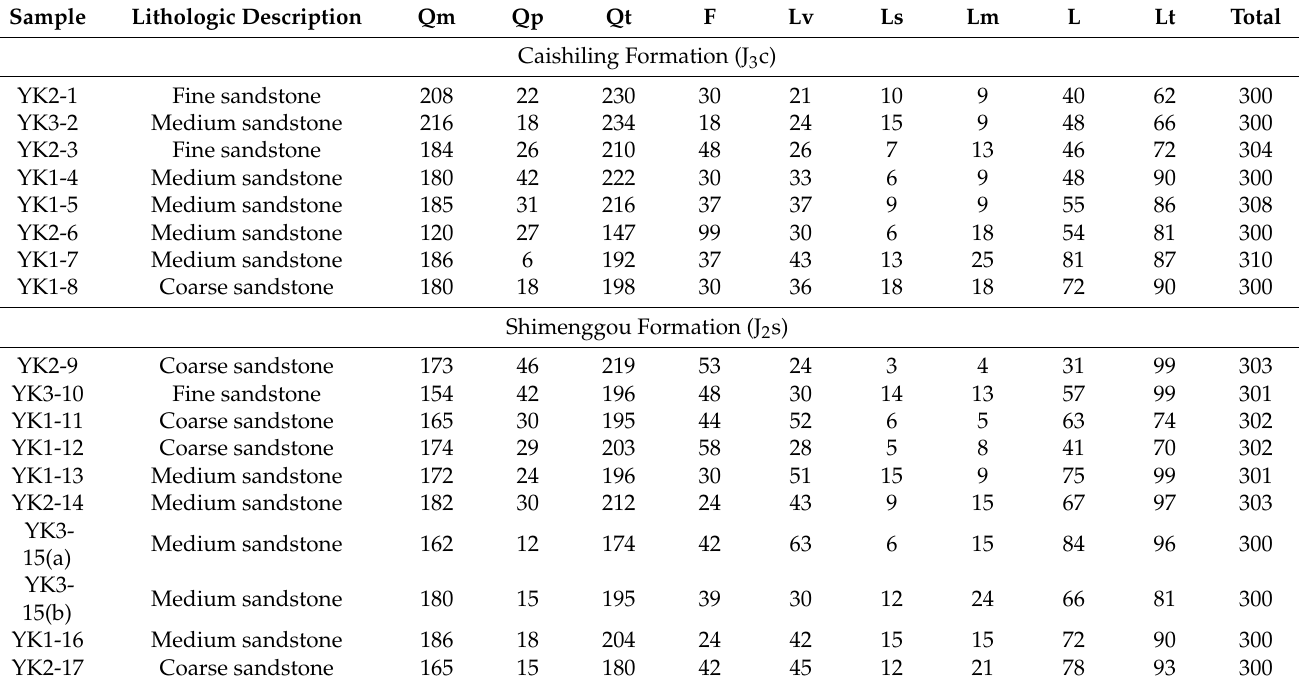
Table 4. The statistics of the detrital grains of Jurassic sandstone samples in the Yuqia